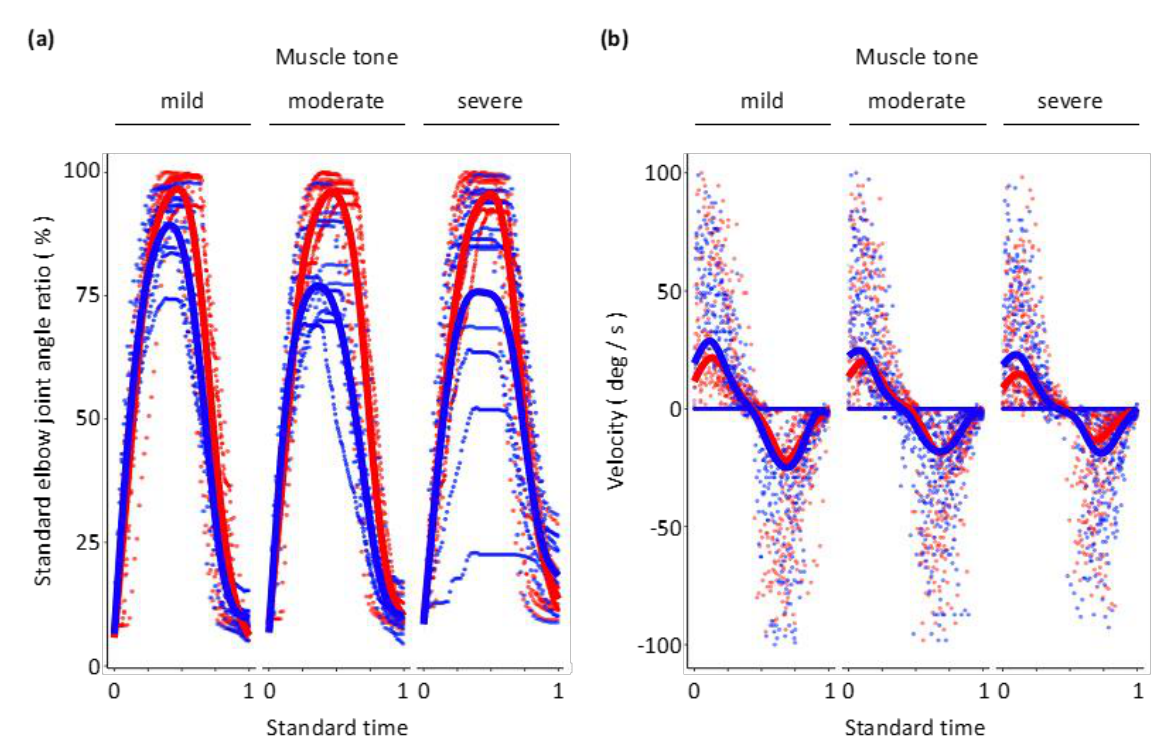
Figure 3. Representative examples of the therapeutic motion techniques of four therapists and four students. ( a ) Variation in standard elbow joint angle rate during therapeutic motion therapy. ( b ) Variation in velocity during therapeutic motion therapy. The standard elbow joint angle rate was normalized by dividing the angle obtained during task performance by the maximum angle obtained from SAMO. The standard time was normalized by movement time during task performance. The red dots represent the standard elbow joint angle rate of therapists. The blue dots represent the standard elbow joint angle rate of students. The solid red line represents the regression curve for the therapists, and the solid blue line represents the regression curve for the students.